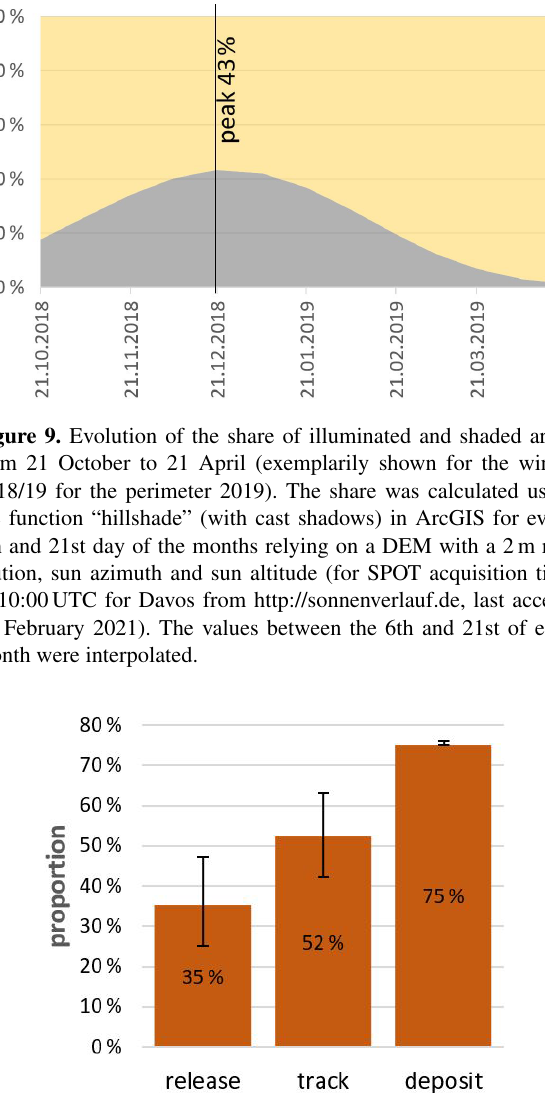
Figure 10. Percentage of radar-detected avalanches where a fea- ture was detected in the deposit, track or release area of avalanches confirmed by ground-truth photographs. The error bars indicate the respective proportions for the two validation